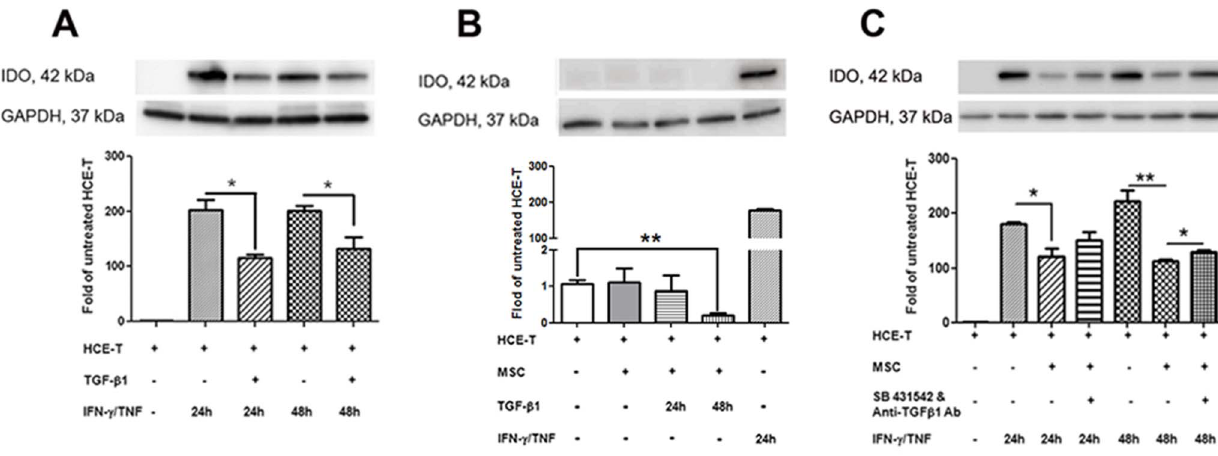
Figure 6. The involvement of TGF- b 1 in the modulatory effect of MSCs on IDO induction. ( A ) Untreated HCE-T, HCE-T monocultures exposed to IFN- c /TNF for 24 h and 48 h with or without 10 ng/ml TGF- b 1 pre-treatment. The cytokines-induced IDO expression was significantly inhibited by TGF- b 1 at 24 h and 48 h (p , 0.05 at both time points). ( B ) HCE-T/MSC co-cultures without and with TGF- b 1 10 ng/ml 24 h treatment express a similar low level of IDO as untreated HCE-T monocultures (less than 2 folds). The IDO expression is significant lower in the HCE-T/MSC co- cultures with 48 h TGF- b 1 treatment compared to the untreated HCE-T monolayers (p , 0.01). While IDO expression from HCE-Ts stimulated with IFN- c /TNF for 24 h was more than 180 folds higher than untreated HCE-Ts. ( C ) Untreated HCE-T, HCE-T monocultures stimulated with IFN- c /TNF for 24 h and 48 h, or HCE-T/MSC co-cultures stimulated by IFN- c /TNF with or without combined SB-431542 (1 m M) and anti-TGF- b 1 antibody (1 m g/ml) treatment. Blockade of the TGF- b 1 signaling pathway in IFN- c /TNF-treated MSC/HCE-T co-cultures using combined neutralizing anti-TGF- b 1 antibody and SB-431542, a TGF- b receptor I blocker, significantly reversed the down-regulatory effect of MSC on IDO expression by 48 h (p , 0.05). The upper panels are representative images of individual western blots for IDO (42 kDa) and GAPDH (37 kDa) expression in HCE-T cells. Each bar summarizes the data from 3 individual experiments (n=3) 6 SEM. *: p , 0.05, **: p , 0.01. The ‘‘ + ’’ or ‘‘ 2 ‘‘ symbol denotes the presence or absence of the denoted treatment or cell type at the